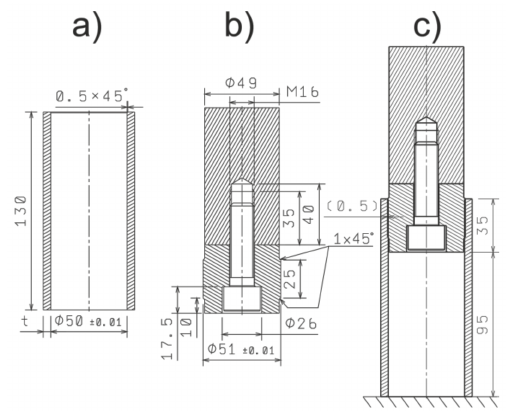
Figure 1. The dimensions of the specimens. Dimensions in millimeters: ( a ) tube; ( b ) expanding element; ( c )